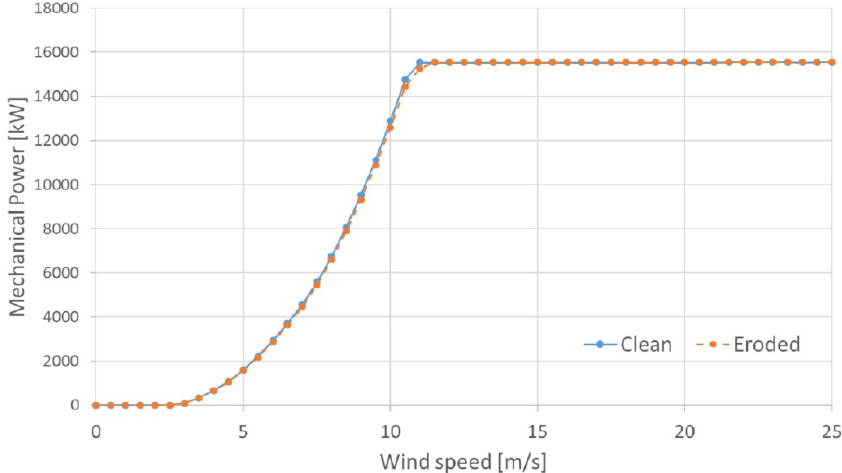
Figure 3. The clean and eroded power curve for the IEA Wind 15 MW reference turbine. From [18]. Reproduced with permission from Skrzypi´nski, W.R.; Bech, J.I.; Hasager, C.B.; Tilg, A.-M.; Bak, C. Optimization of the erosion-safe operation of the IEA Wind 15 MW Reference Wind Turbine. J.